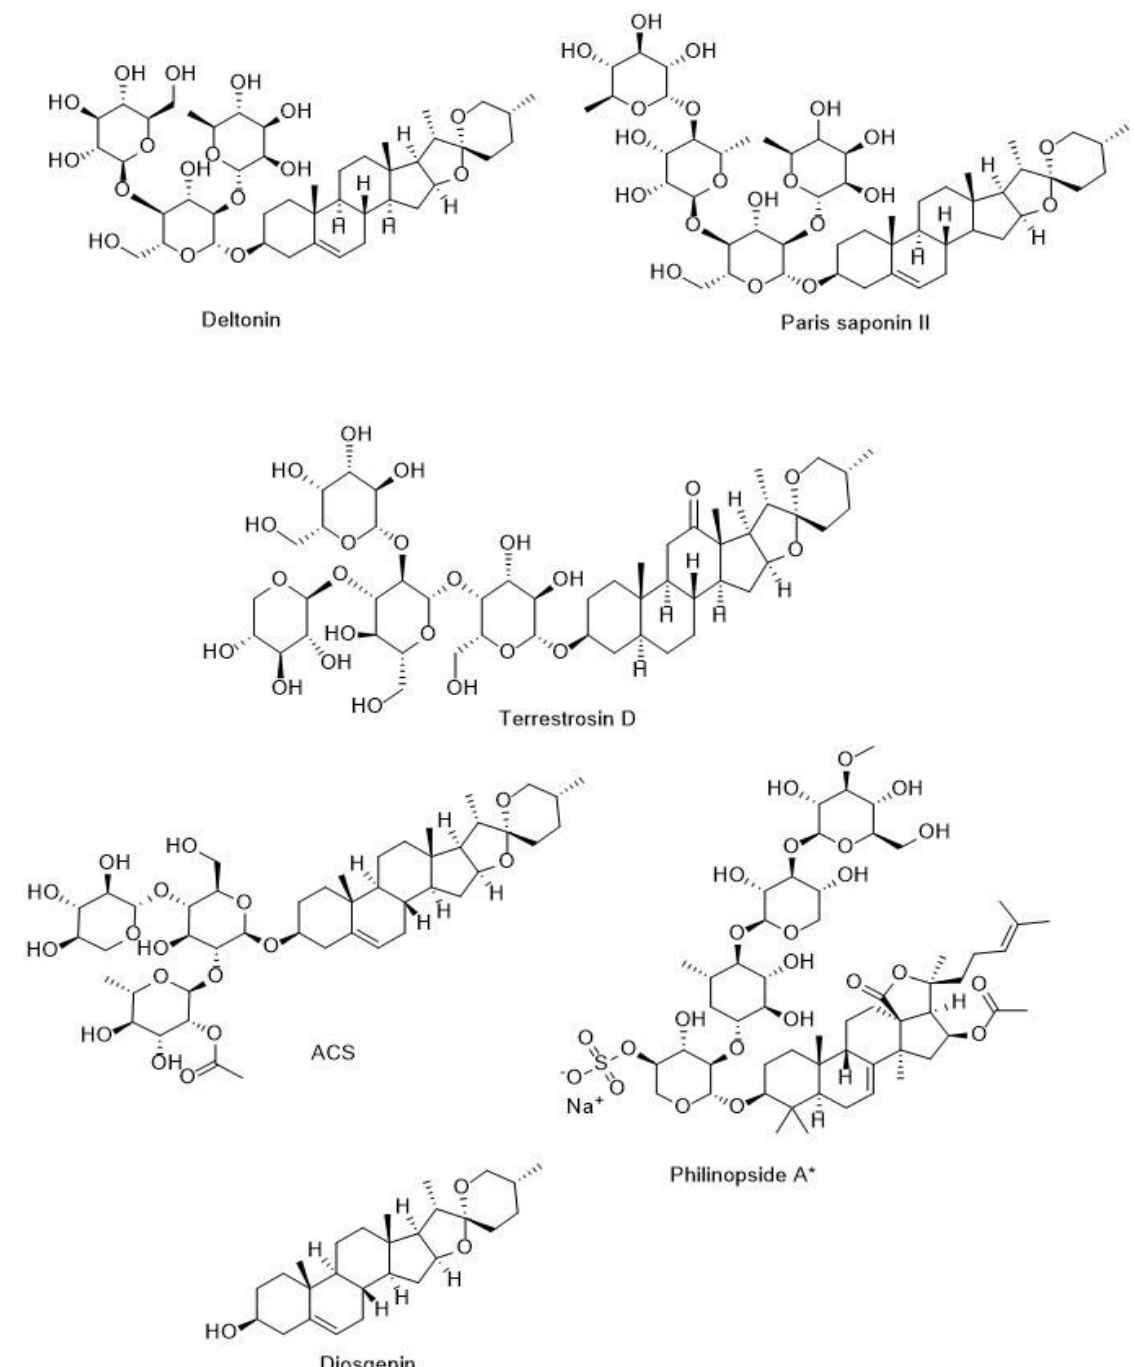
Figure 4. Chemical structure of some anti-angiogenic steroidal saponin. * Philinopside A: is a sulfated saponin isolated from marine organism.